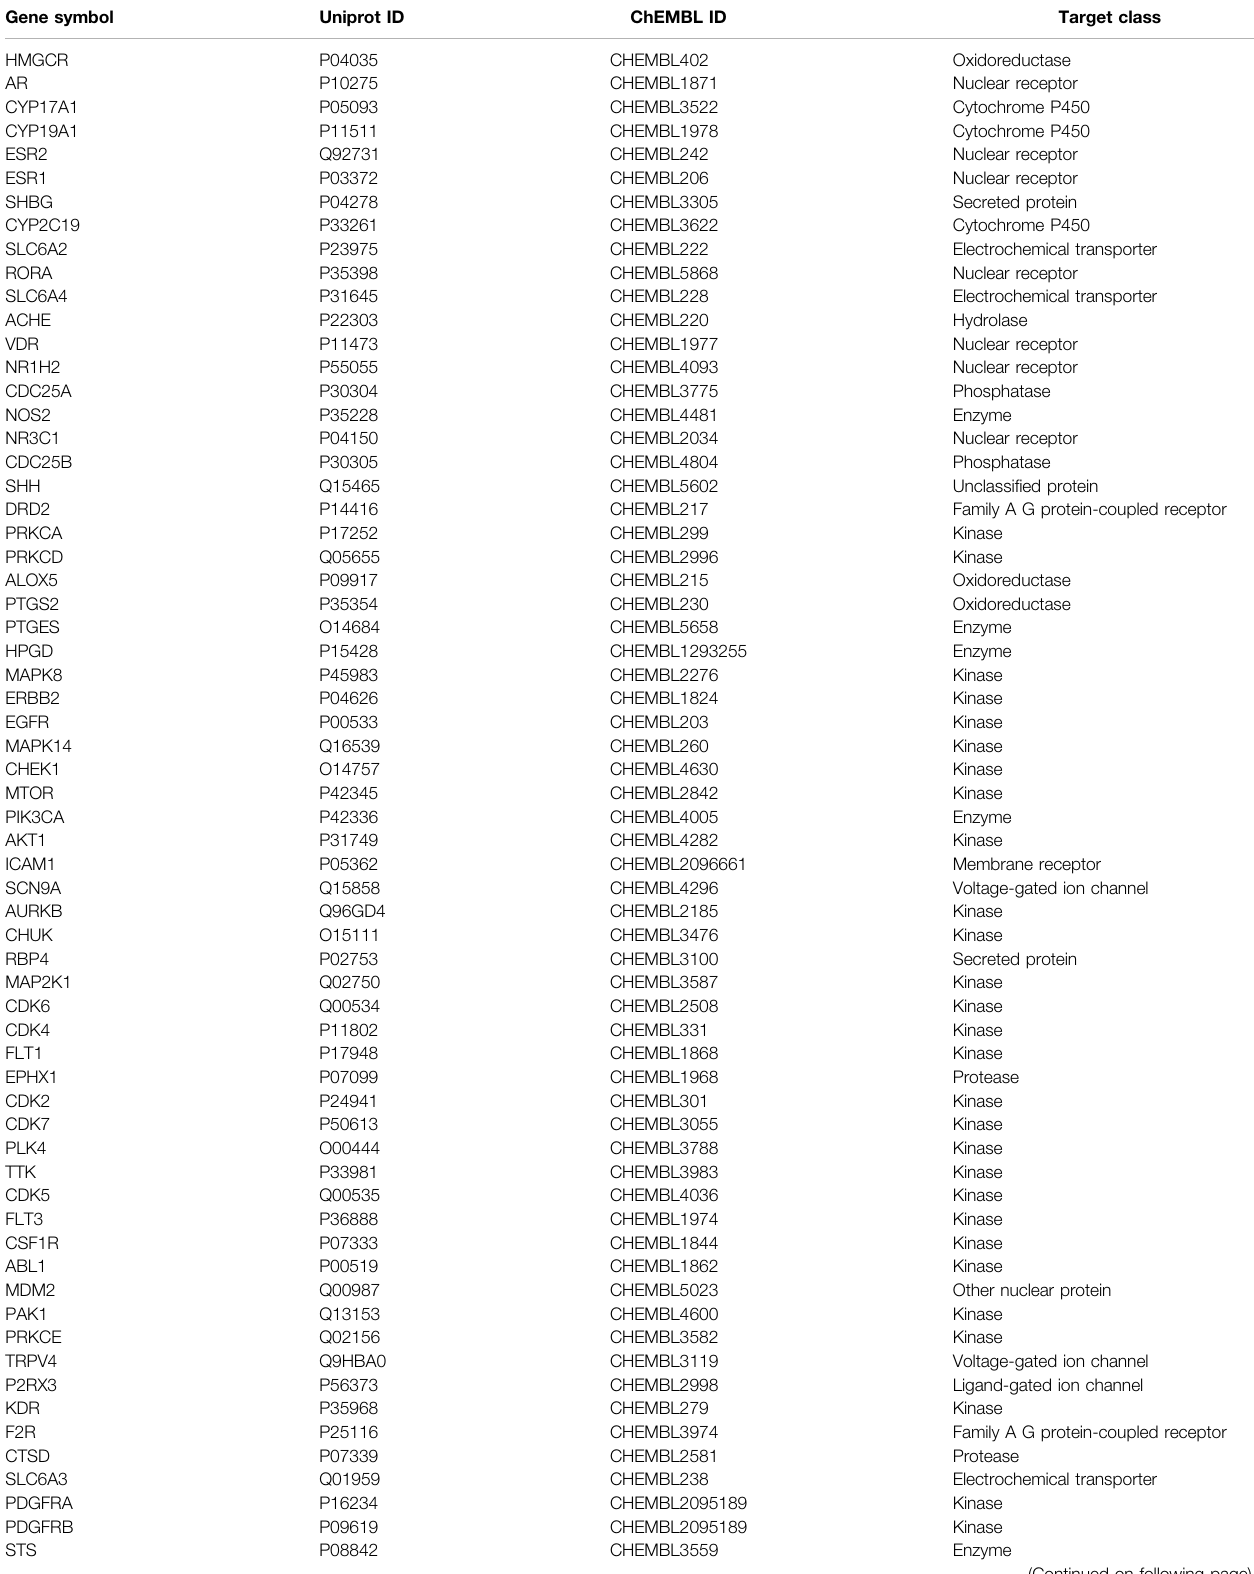
TABLE 2 | The 212 intersecting potential targets of HNSCC and